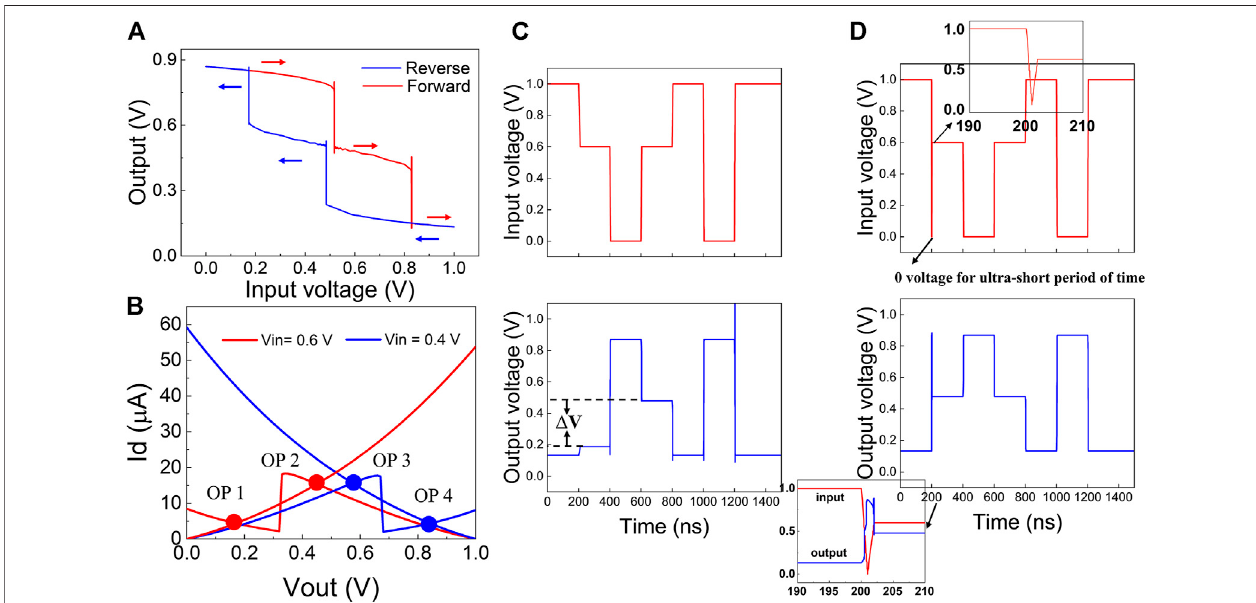
FIGURE 6 | Analysis and solution to the hysteresis problem. (A) Dual DC sweep of the NC2D-based ternary inverter. (B) Load-line analysis of the hysteresis of the ternaryinverter. (C) Transient simulations ofthe NC2D-basedternaryinverter using thetraditionalinputwaveform. (D) . Transient simulations oftheNC2D-based ternary inverter using the new input waveform scheme. The aforementioned inset is the zoom-in details of the added negative pulse. The following inset shows the zoom-in rise and fall details when the inverter crosses the hysteresis region at around 200 ns (0 – 1 logic level transition).